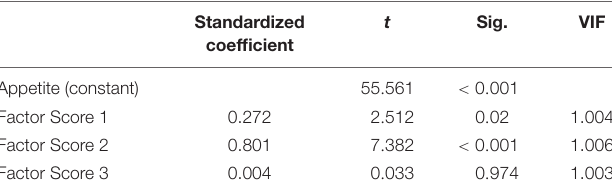
Standardized coefficient, t-test value and significance, and collinearity statistics for each factor are listed. In this analysis, All of VIFs < 10 were obtained. The Factor 2 standardized coefficient was